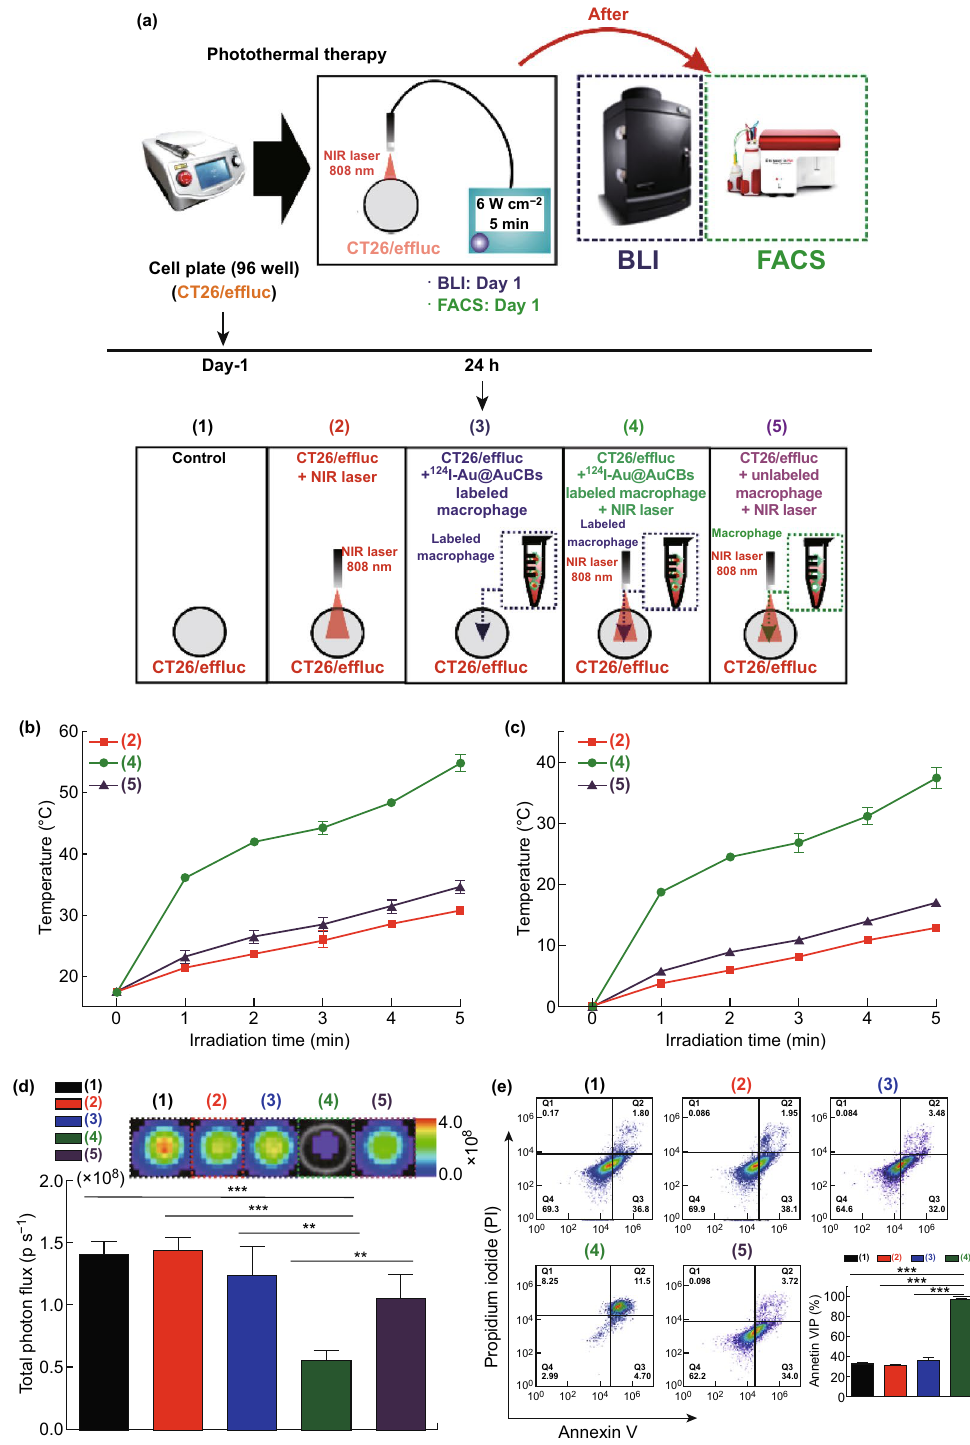
Fig. 5 Induction of cytotoxic effects in colon cancer cells via photothermal therapy using 124 I‑Au@AuCB‑labeled macrophages. a Scheme for 124 I‑Au@ AuCB‑labeled macrophage‑mediated PTT in vitro. b Temperature and c temperature changes ( Δ temperature) in unlabeled macrophages and 124 I‑Au@ AuCB‑labeled macrophages after irradiation with an NIR laser for 5 min. The red line indicates temperature changes in media irradiated with an NIR laser. d , e Evaluation of cell proliferation and apoptosis levels in CT26/FM alone (black), CT26/FM + NIR laser (red), CT26/FM + 124 I‑Au@AuCB‑labeled macrophages (blue), CT26/FM + 124 I‑Au@AuCB‑labeled macrophages + NIR laser (green), and unlabeled macrophages alone + laser (purple) using in vitro bioluminescent imaging and annexin V/PI staining, respectively. **P < 0.001, ***P <